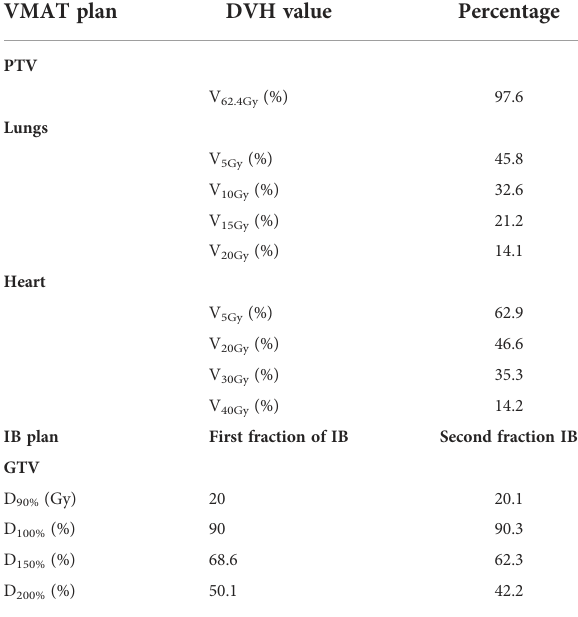
TABLE 1 Dose-volume histograms of the Planning Target Volume (PTV), lungs, and heart, during external beam radiotherapy of the left porta of the lung, and GTV during the fi rst and second interstitial